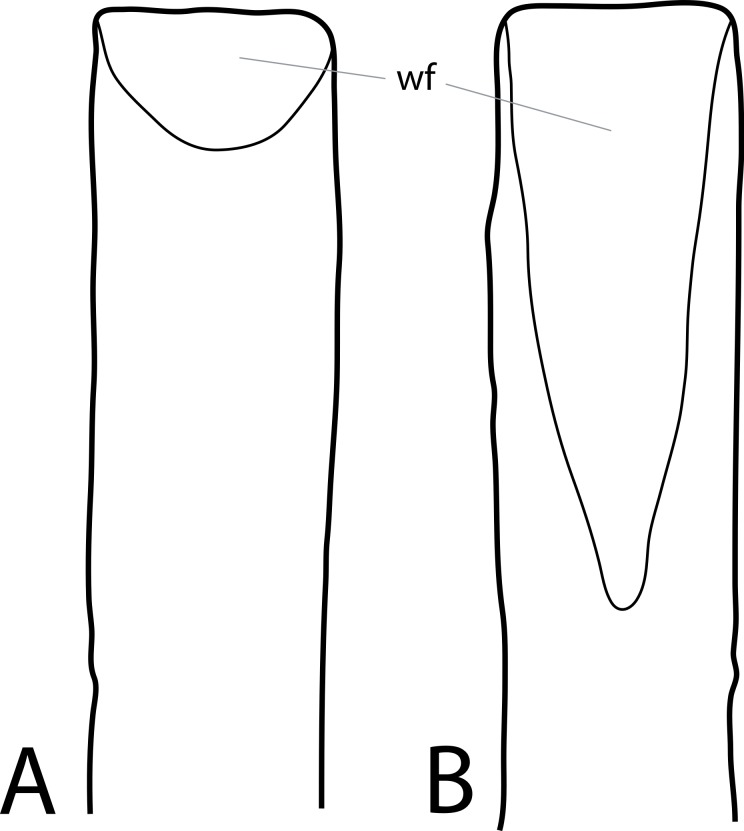
Tooth of Nigersaurus in labial (A) and lingual (B) view.Note the paired, planar wear facets typical for Rebbachisauridae (C117-1; C118-0). Abb.: wf, wear facet. Figure traced from Whitlock (2011b).